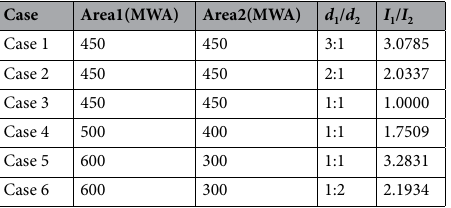
Table 2. Load data for wind turbines in the dual regional system grid.